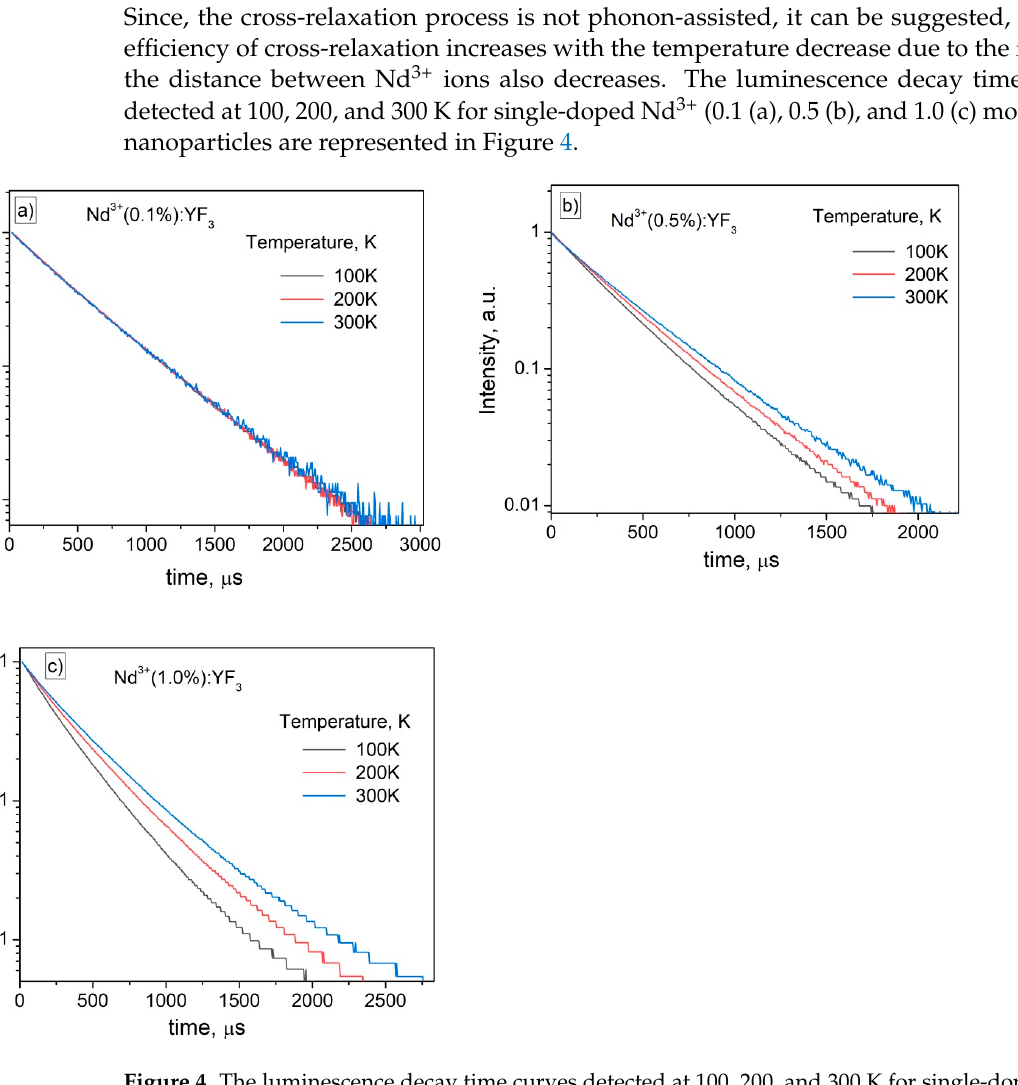
Figure 4. The luminescence decay time curves detected at 100, 200, and 300 K for single-doped Nd 3+ (0.1 ( a ), 0.5 ( b ), and 1.0 ( c ) mol.%):YF 3 nanoparticles. λ ex = 790 nm ( 4 I 9/2 – 4 F 5/2 absorption band of Nd 3+ ), λ em = 863 nm ( 4 F 3/2 – 4 I 9/2 emission band of Nd 3+ ). In can be seen, that for both Nd 3+ (0.5 and 1.0 mol.%):YF 3 samples, decay time de- creases with the temperature decrease. The curves can be well described by a sin- gle-exponential function. In particular, for Nd 3+ (1.0 mol.%):YF 3 sample the decay times were 277, 328, and 358 μ s at 100, 200, and 300 K, respectively. In its turn, for Nd 3+ (0.5 mol.%):YF 3 sample, the decay times were 370, 389, and 412 μ s at 100, 200, and 300 K, re- spectively. The Nd 3+ (0.1 mol.%):YF 3 sample demonstrates ~472 μ s decay time. The de- crease of decay time with the increase of Nd 3+ concentration can be explained by con- centration quenching phenomenon. It can be proposed, that at 0.5 mol.% the cross-relaxation between Nd 3+ ions takes place in contradistinction from 0.1 mol.% Nd 3+ concentration. The decrease of decay times with temperature can be explained by the decrease of distances between Nd 3+ with tem- perature (thermal expansion phenomenon) that leads to the increase of cross-relaxation efficiency. It can be concluded, that for Nd 3+ (0.1%):YF 3 nanoparticles the excitation en- ergy does not scatter between Nd 3+ ions. Since, the (1.0 mol.%):YF 3 showed the lowest signal-to-noise ratio, we chose 0.1 and 0.5% Nd 3+ concentration in order to synthesize double doped Nd 3+ , Yb 3+ :YF 3 and compare their performances.